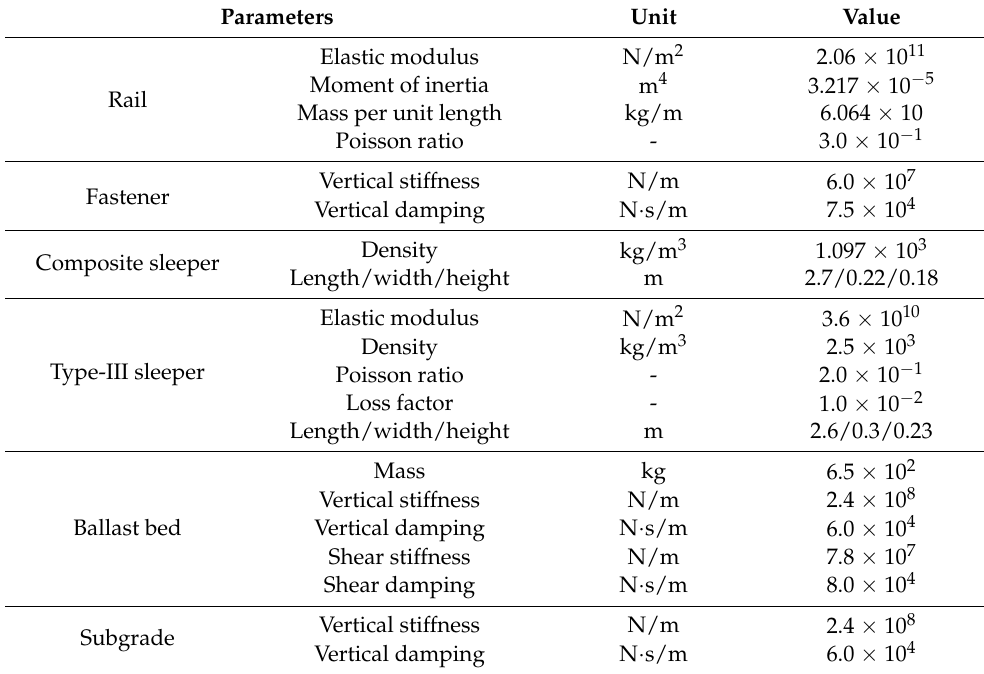
Table 3. The parameters of the